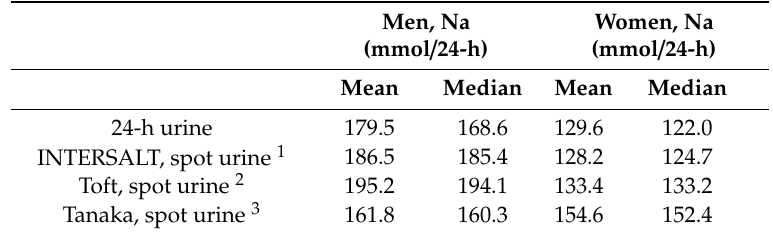
Table 5. Mean sodium (Na) excretion measured by 24-h urine and estimated by spot urine in 232 men and 243 women in the seventh wave of the Tromsø study